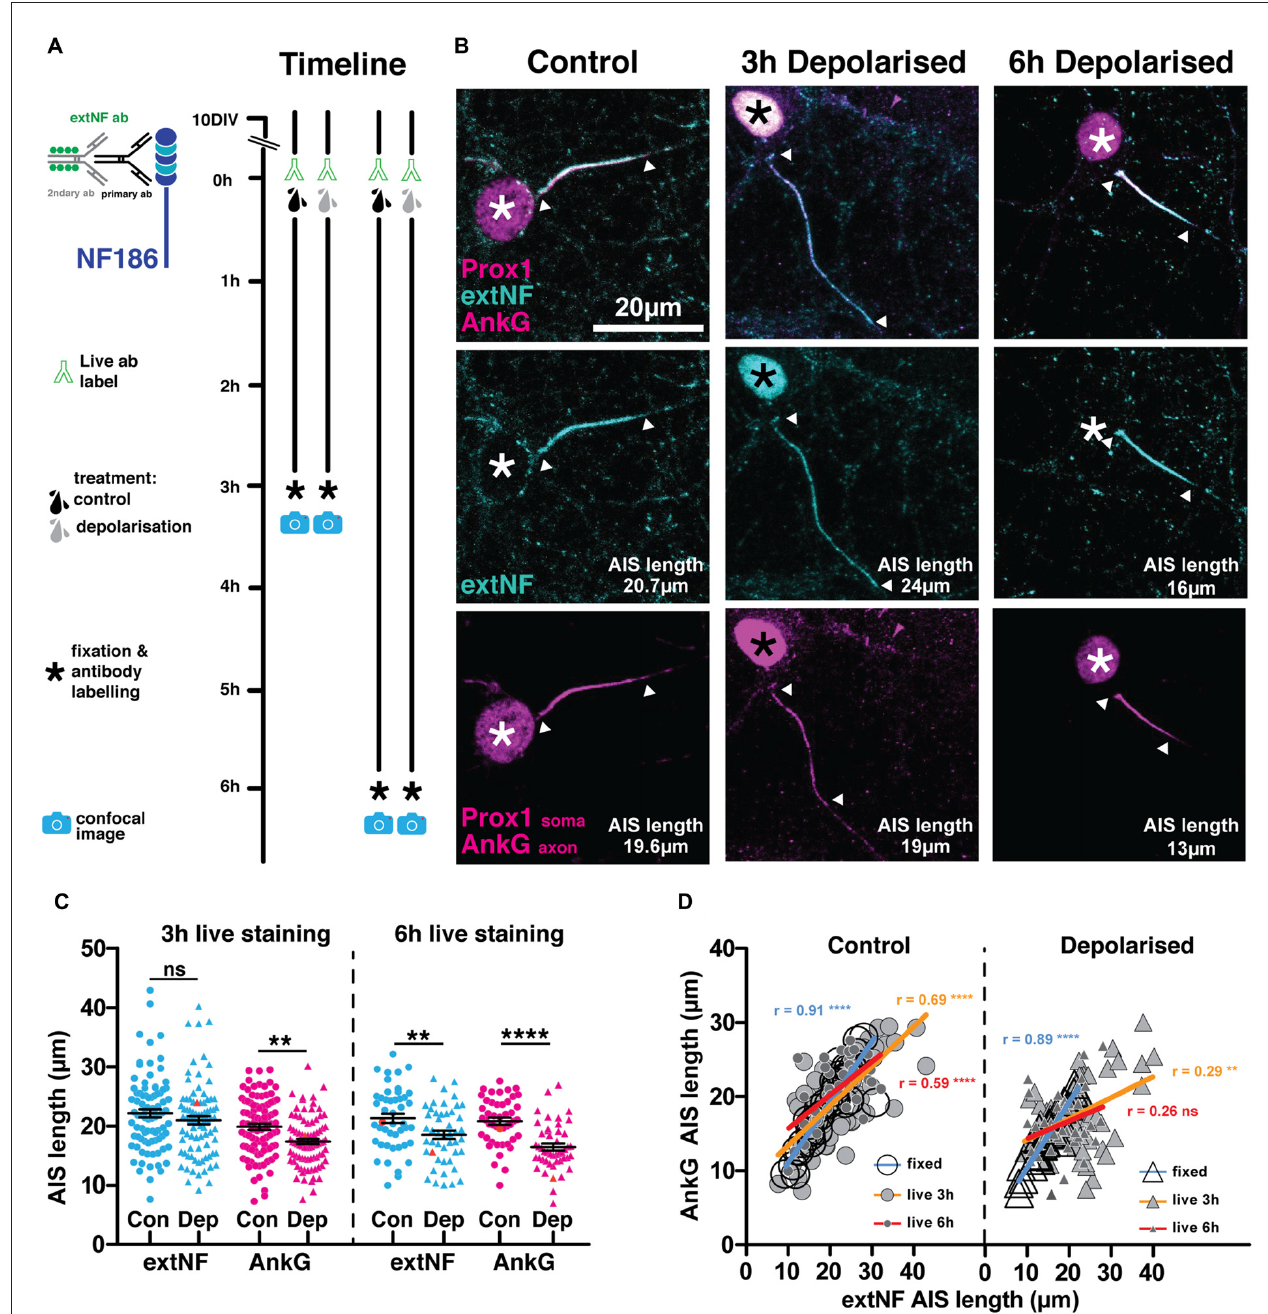
FIGURE 2 | Live AIS label with a neurofascin antibody does not report rapid structural plasticity. (A) Diagram of the experimental timeline used to test the extNF antibody as an AIS live label method. (B) Example maximum intensity projections of control or 3 h/6 h depolarized dentate granule cells (DGCs) bearing extNF live-labeled AISs (cyan) and stained post fixation with antibodies against AnkG (magenta, axonal) or prox1 (magenta, nuclear, white asterisks; cyan nuclear, black asterisks—due to secondary antibody contamination); arrowheads, DGC AIS start and end positions. (C) Plot shows distributions of AIS lengths measured with extNF applied live for either 3 or 6 h (blue) and AnkG (magenta) from control (Con) or depolarized (Dep) DGCs. Each point represents a single cell; black lines show mean ± SEM; orange symbols, values from example cells displayed in (B) ; Bonferroni post-test after two-way repeated measures ANOVA; ns, non-significant; ∗∗ p < 0.01; ∗∗∗∗ p < 0.0001. (D) Correlation analysis for AISs labeled with both extNF and AnkG in the same neuron under control (dotted symbols) or depolarized (triangle symbols) conditions in three separate experiments: extNF post fixation (large open circles and triangles), extNF applied live for the duration of a 3 h treatment (medium sized light gray filled dots and triangles), extNF applied live for the duration of a 6 h treatment (small, dark gray filled dots and triangles). Lines show best linear regression fit for extNF applied post fixation (blue), live for 3 h (orange) or live for 6 h (red); Pearson’s correlation; ∗∗ p = 0.008; ∗∗∗∗ p < 0.0001; ns,